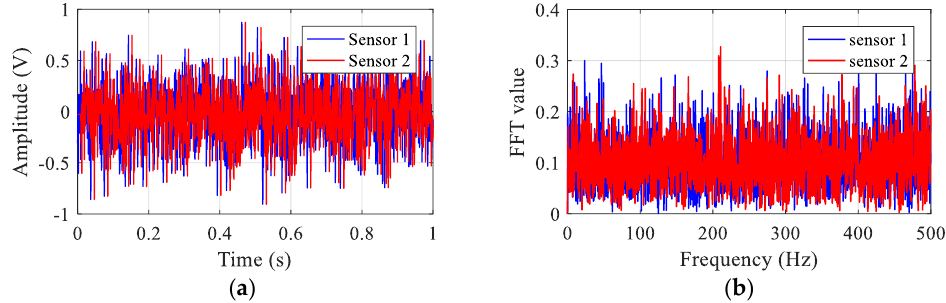
Figure 5. Simulated signals in the pipe with leakage: ( a ) in the time domain; ( b ) in the frequency domain.